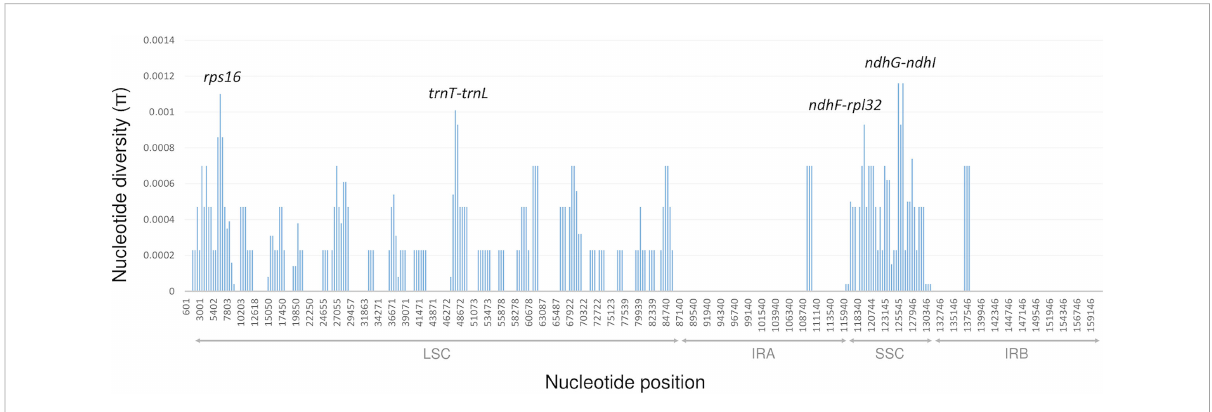
FIGURE 5 Sliding window analysis of the chloroplast genomes of the 43 independent T. esculentum individuals (window length: 1200 bp, step size: 400 bp). The x -axis shows the midpoint position of each window. 30,949-31,218, where the 230 bp inversion is located was excluded from this analysis (Figures S1, 2).